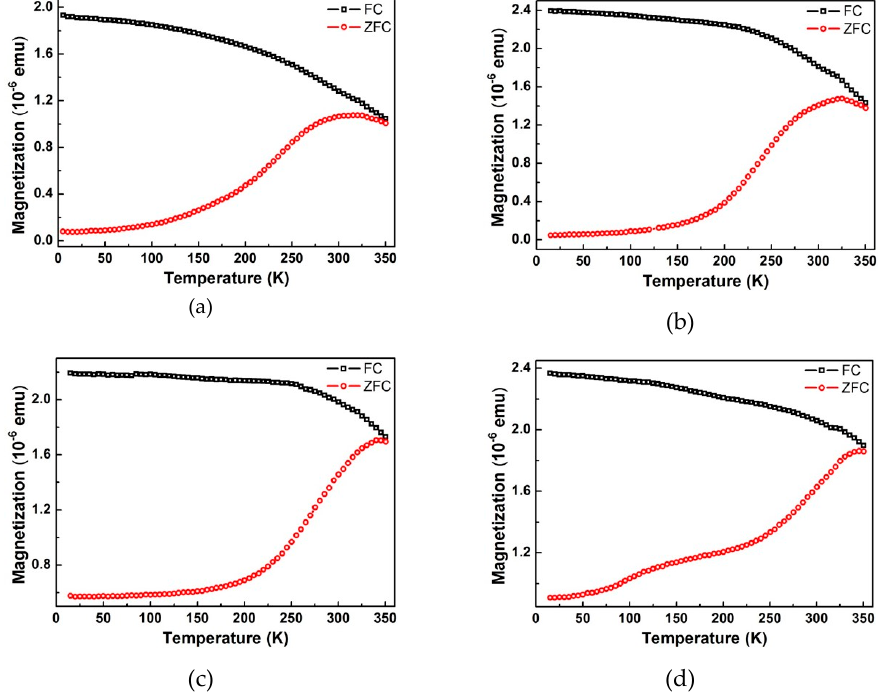
Figure 9. Temperature dependence of the in-plane magnetization for nanodots prepared from ( a ) SEO-26k, ( b ) SEO-49k, ( c ) SEO-89k and ( d ) SEO-136k. The black and red curves are the field-cooling and zero-field-cooling curves, respectively.